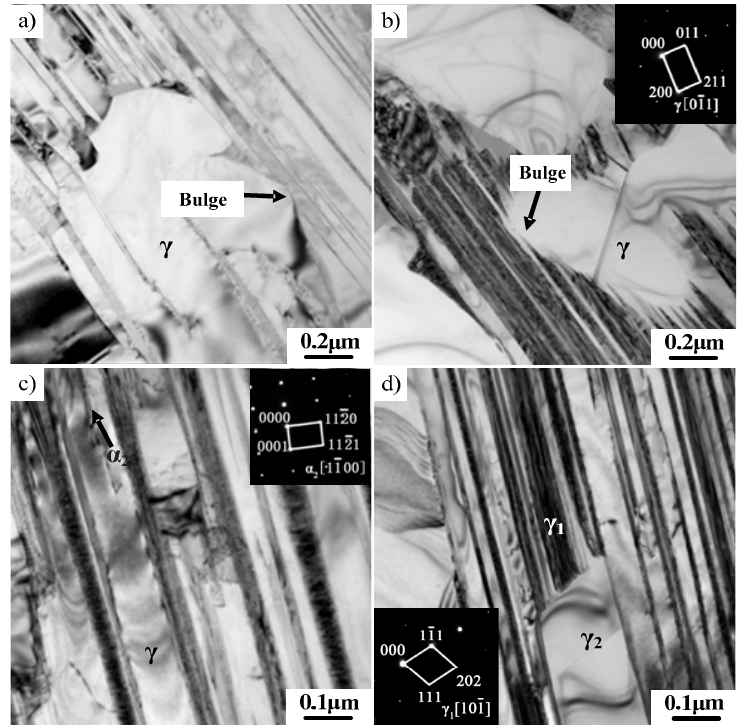
Figure 7. TEM images showing the coarsening mechanism of γ lamellae. ( a , b ) The bulging of phase boundaries, ( c ) the decomposition of α 2 lamellae, ( d ) the decomposition of the γ